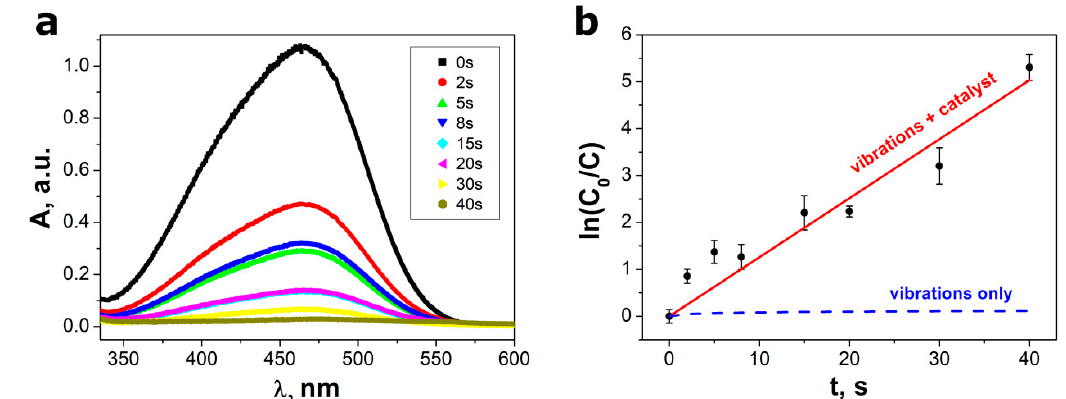
Figure 4. ( a ) An influence of piezocatalysis time on UV–vis absorption spectra of the MO aqueous solutions; ( b ) plots of ln(C 0 / C) versus the ultrasonic vibration time. Red line in graph ( b ) represents the best fitted dependence described by Equation (1). Blue dashed line in graph ( b ) shows data registered in control experiments conducted under ultrasonic vibration without SbSI piezocatalyst. Piezocatalysis was performed using VCX-750 (Sonics & Materials, Inc.) ultrasonic reactor with ultrasound frequency f = 20 kHz and power P = 750